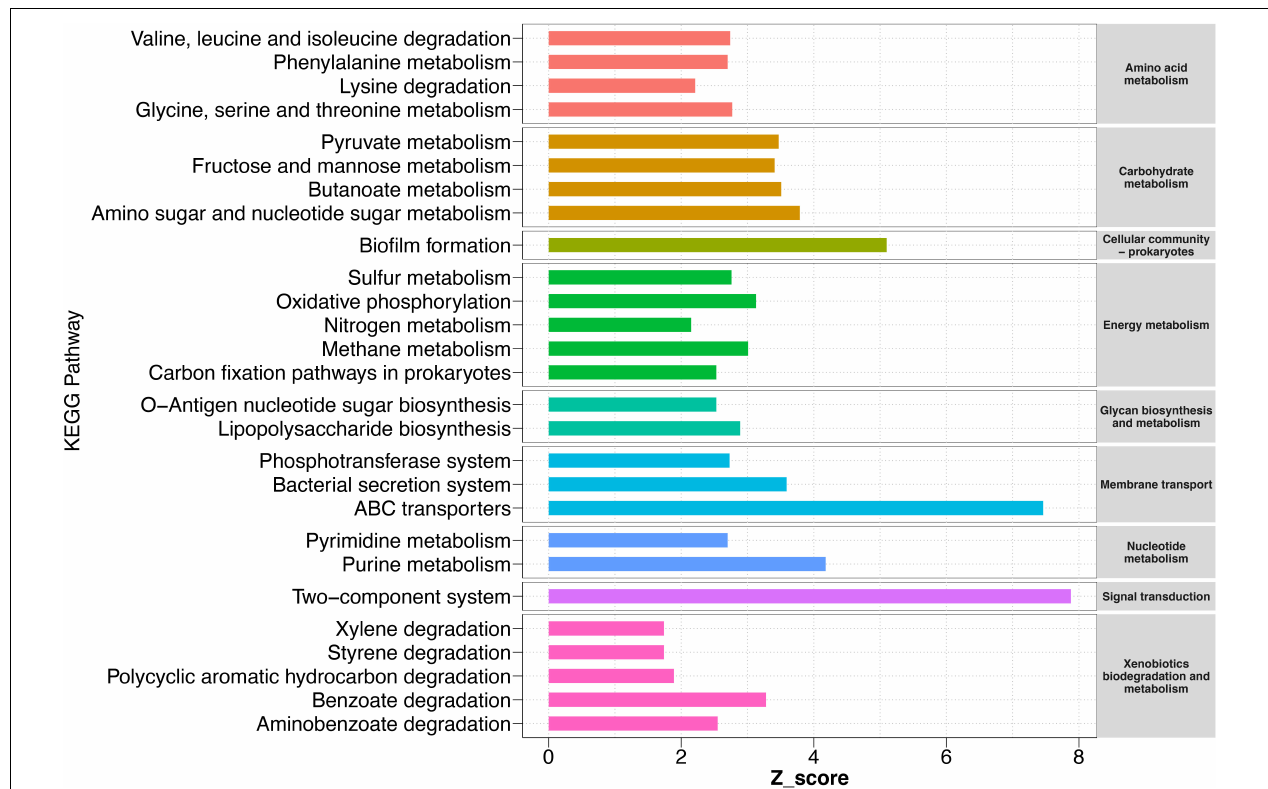
FIGURE 6 | KEGG pathways of rhizosphere bacteria sample in different soils. Pathways are enriched in sandy and loam soil compared to black soil and farm soil. Pathways with a significant difference in reporter score ( > 1.64, enriched in sandy soil and sandy loam soil) were retained. Reporter scores > 1.64 are shown on the map. Different colors represent different metabolic pathways of KEGG level 2 (right) and level 3